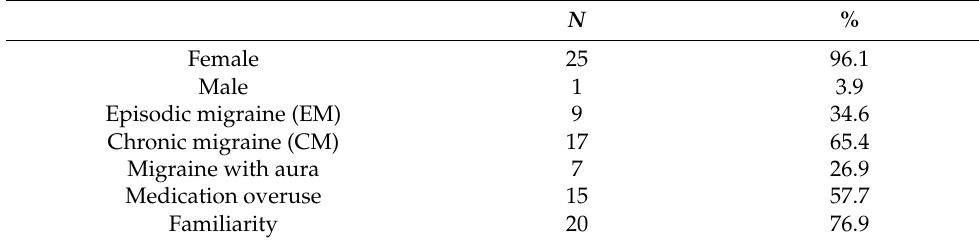
Table 1. Profiles of enrolled